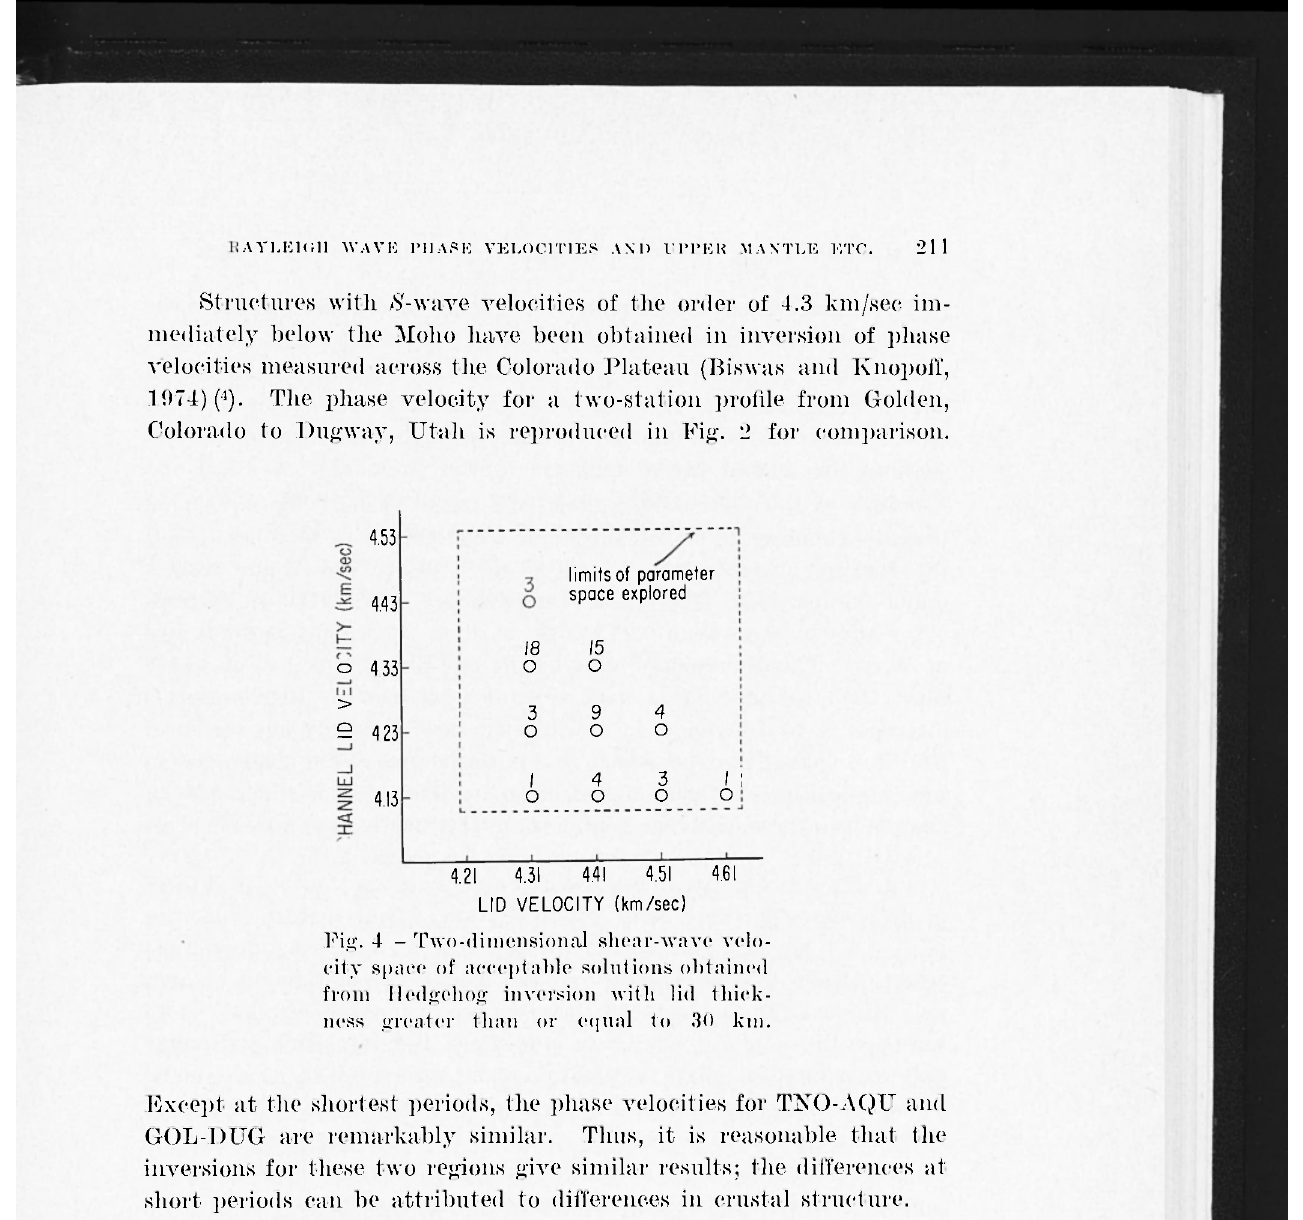
Fig. 4 - Two-dimensional shear-wave velo- city space of acceptable solutions obtained from Hedgehog inversion with lid thick- ness greater than or equal to 30